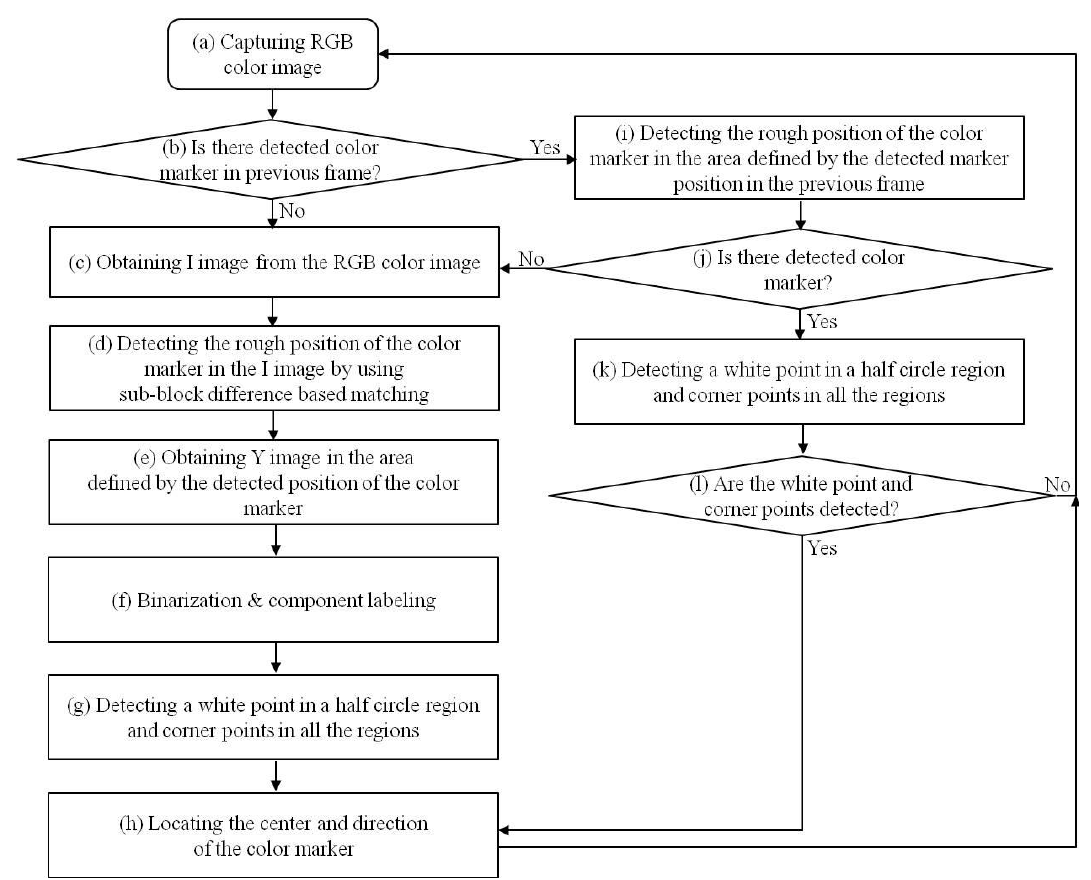
Figure 6. Flowchart of detection process of the center and direction of color marker.